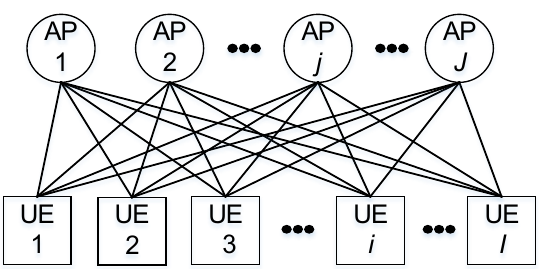
Figure 2. Example of a factor graph consisting of variable nodes, AP j , ∀ j ∈ J , and factor nodes, UE i , ∀ i ∈ I